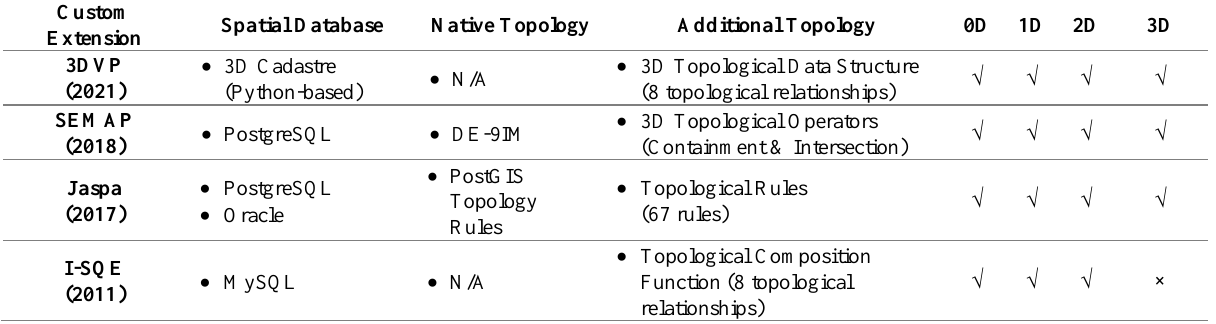
Table 3. Custom topological extensions for spatial